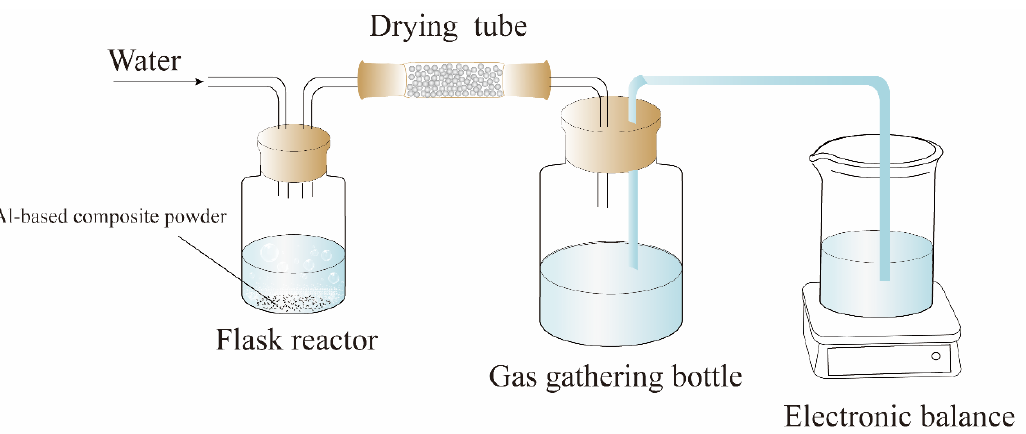
Figure 2. The schematic diagram of the experimental device used for hydrogen yield measurement.